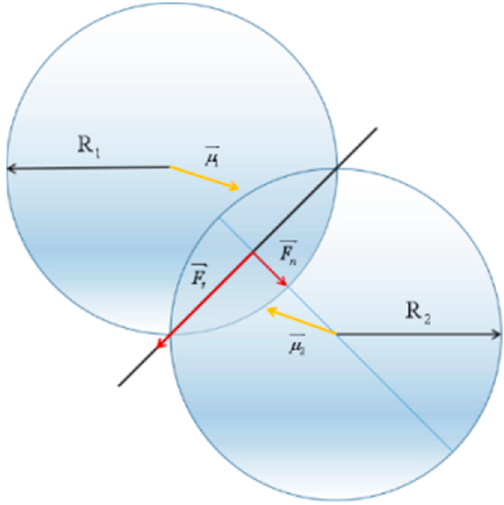
Figure 3. The collision force acting on a certain element of the spheres. According to Hertz contact theory, the mathematical description of tangential and normal components is given by Equations (7) and (8):